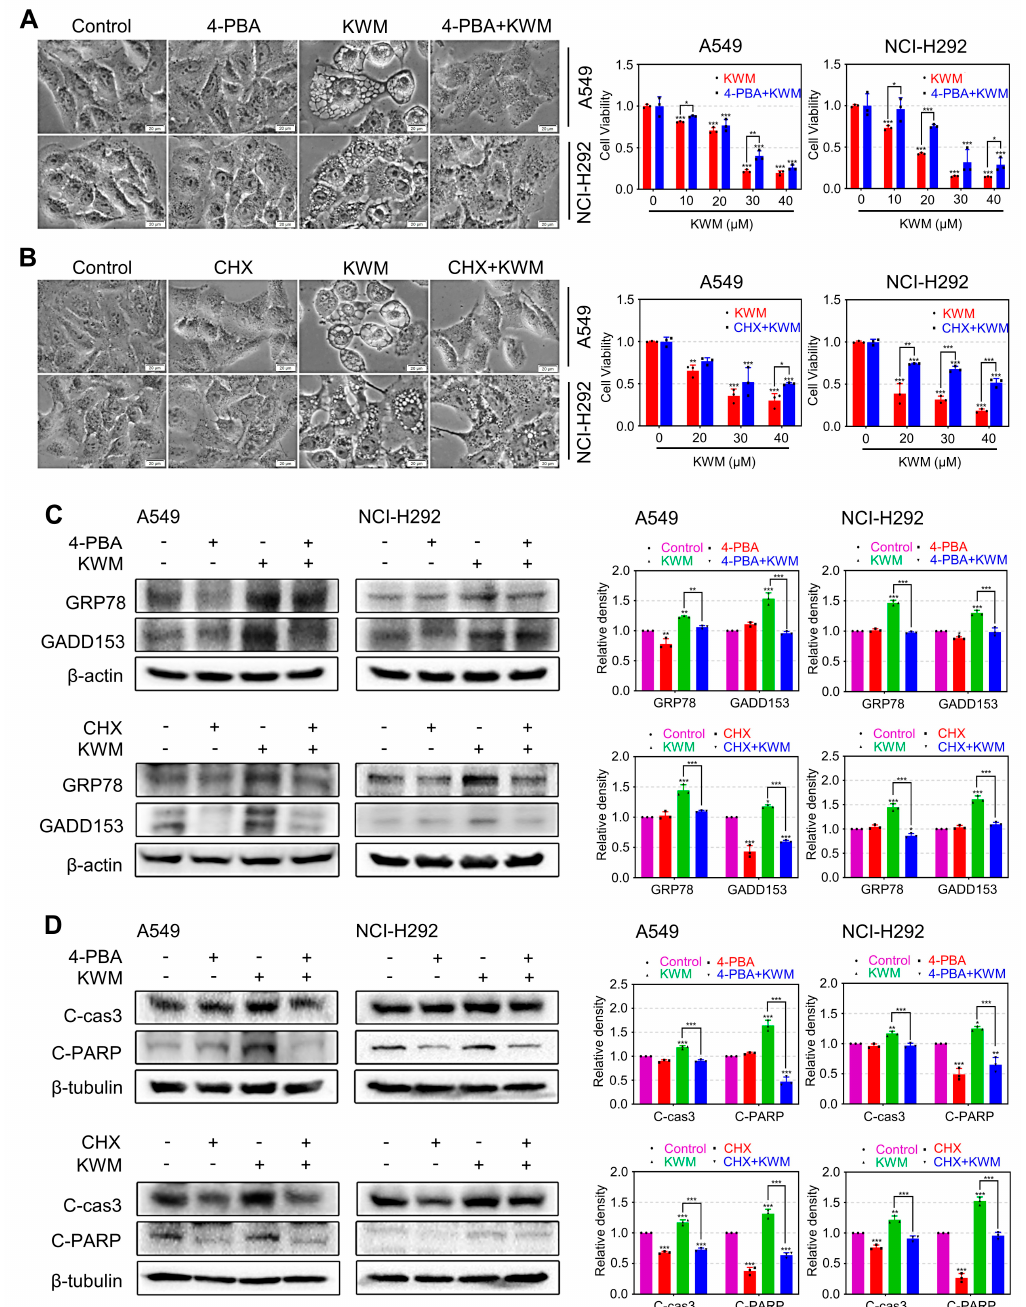
Figure 7. KWM-induced apoptosis and paraptosis mediated by ER stress. ( A , B ) Cells were pretreated for 2 h in the presence or absence of 2 mM 4-PBA or 5 µ M CHX prior to treatment of KWM (20 µ M) or DMSO. Phase-contrast images were captured after 12 h. Cell viability was determined by MTT assay after 48 h. ( C , D ) Cells were pretreated with 4-PBA (2 mM) or CHX (5 µ M) for 2 h and then treated with or without KWM (20 µ M) for additional 16 h ( C ) or 24 h ( D ), cell lysates were subjected to immunoblotting for GRP78 and GADD153, β -actin was used as a loading control ( C ). And cell lysates were subjected to immunoblotting for apoptosis associated proteins, β -tubulin was used as a loading control ( D ). Results were from three separate experiments. Values were expressed as mean ± SD, n = 3. * p < 0.05, ** p < 0.01, and *** p < 0.001 versus respective control